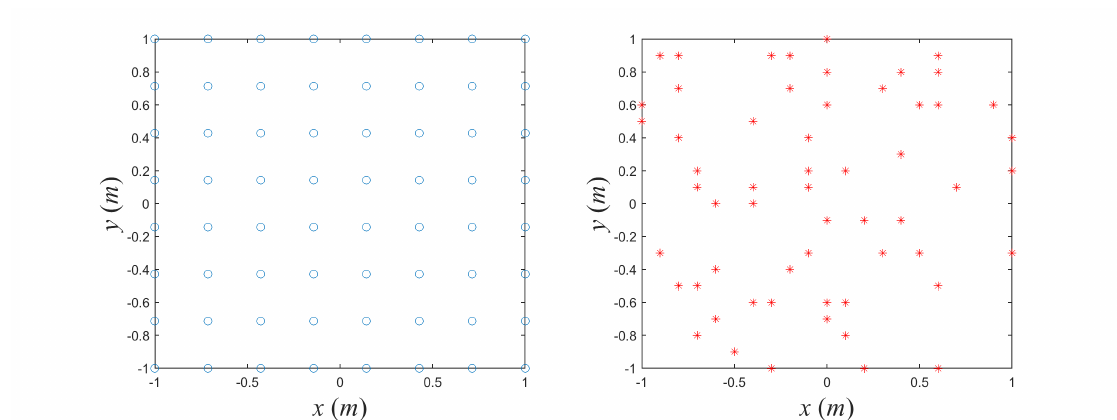
Figure 13. The comparison of initial uniform array configuration and optimized configuration.